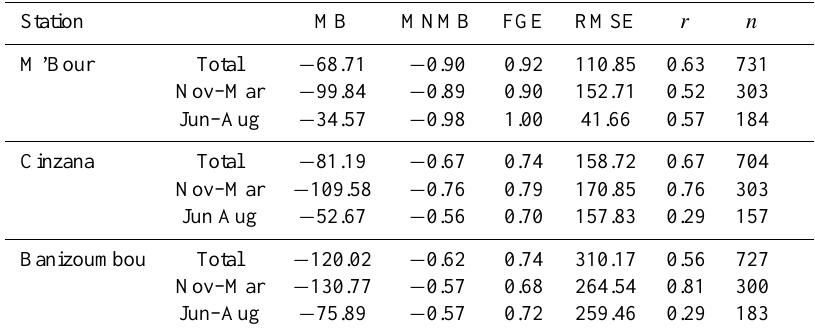
Table 4. Skill scores quantifying the level of agreement between MACC-II surface dust concentrations and AMMA-PM 10 daily means for 2007–2008. Station MB MNMB FGE RMSE r n M’Bour Total − 68.71 − 0.90 0.92 110.85 Nov–Mar −